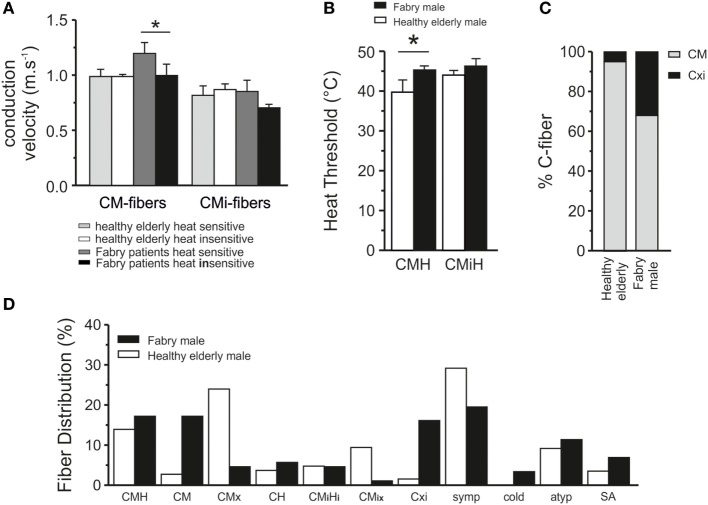
Properties of nociceptive fibers in Fabry disease patients. (A) Conduction velocity (CV) in afferent C-fibers with and without heat response in patients with Fabry disease and healthy elderly controls. The mechano-responsive (CM) C-fibers (left side) with heat responses from patients with Fabry disease had higher CVs than those without heat responses (p < 0.05; ANOVA, post hoc LSD). No significant differences were found in CVs of mechano-insensitive (CMi) C-fibers. (B) Heat thresholds in CM C-fibers were significantly higher in patients with Fabry disease than in healthy controls (p < 0.05; ANOVA, post hoc LSD). The thresholds of CM in patients with Fabry disease were more in the range of CMi C-fibers, which have physiologically higher heat threshsolds. (C) In patients with Fabry disease significantly more often C-fibers are found (p < 0.05, χ2 test), which have biophysical properties of mechano- and heat-responsive C-fibers (CMH) fibers, but show no mechanical response (CXi) than in healthy subjects. (D) Proportions of C-fiber subclasses in human patients with Fabry disease and elderly healthy controls. In patients with Fabry disease more afferent C-fibers without heat responsiveness and more fibers without heat and mechanical responsiveness were observed than in healthy controls.